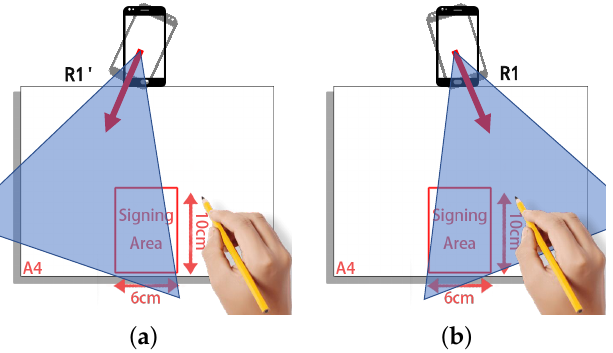
Figure 14. Experiment setting of the smartphone orientation. ( a ) The hand utilized to sign is out of the sensing range when the smartphone rotates 23 degrees clockwise. ( b ) The movement of the hand while signing can be captured by SilentSign since our hand is still within the sensing range.